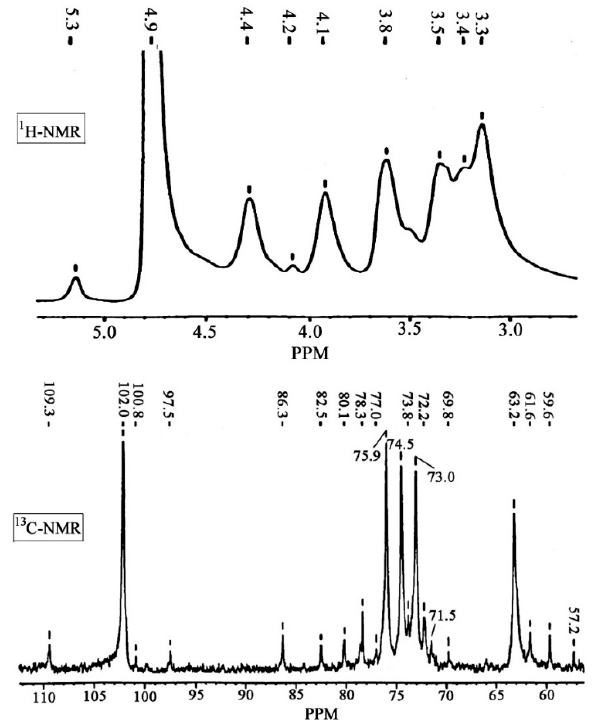
Figure 3. 1 H and 13 C NMR spectra of the hemicelluloses H 65 obtained from sweet maize stems.